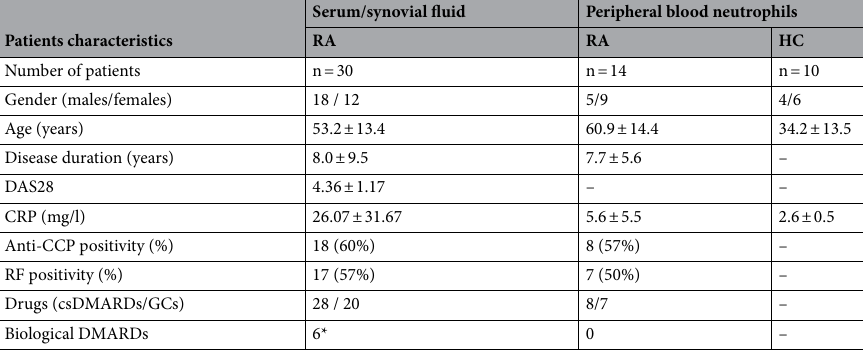
Table 1. Characteristics of patients with rheumatoid arthritis (RA) and healthy controls (HC). Anti-CCP anti-cyclic citrullinated peptide antibody, CRP C-reactive protein, DAS28 disease activity score in 28 joints from CRP, csDMARDs conventional synthetic disease-modifying antirheumatic drugs, GCs glucocorticoids, RF rheumatoid factor IgM. *Out of 6 patients, 2 were treated with tocilizumab, 1 with ofatimumab, 1 with humira, 1 with Enbrel and 1 with anti-IL-17 therapy. Data are expressed as the mean ± SD unless stated